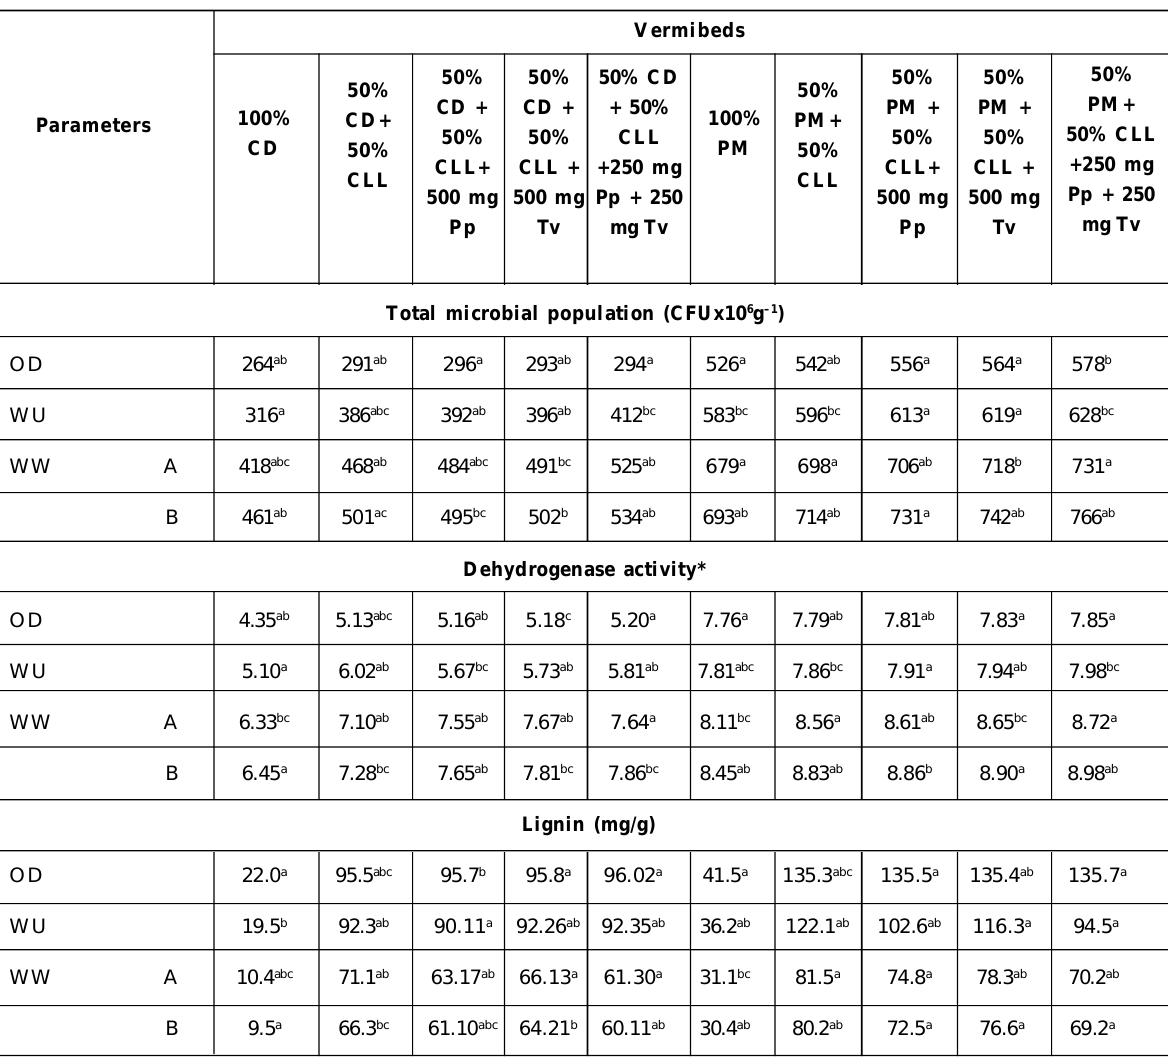
Table 4: Biological composition of vermifertilizer obtained through integrated system of vermicomposting — lignocellulosic wastes (n=6; X